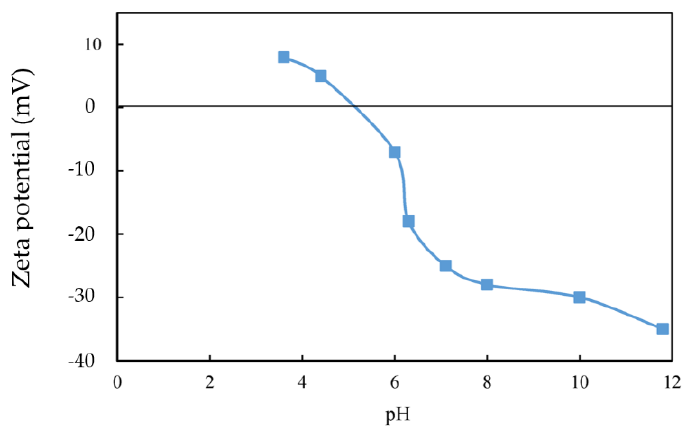
Figure 2. Zeta potential as a function of pH, adapted from Filippov et al. [42].